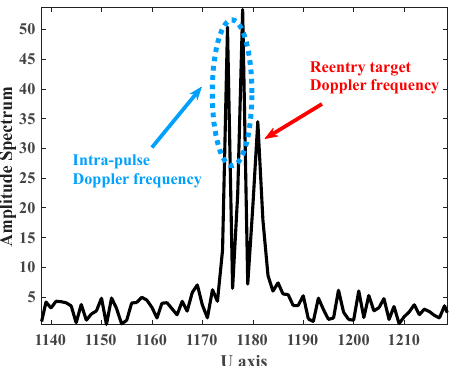
Figure 7. Slicing diagram of the target echo signal’s time-frequency results with PSh. In a single period, the IaD-frequency causes an increase in the number of peaks on the one-dimensional range profile, and the deviation of the peak position between multi- ple periods is caused by the bandwidth limitation of the radar transmission signal and the Doppler frequency between pulses.